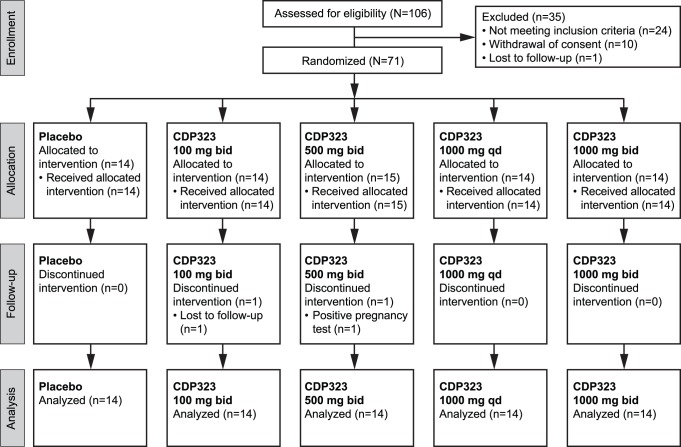
Subject disposition.